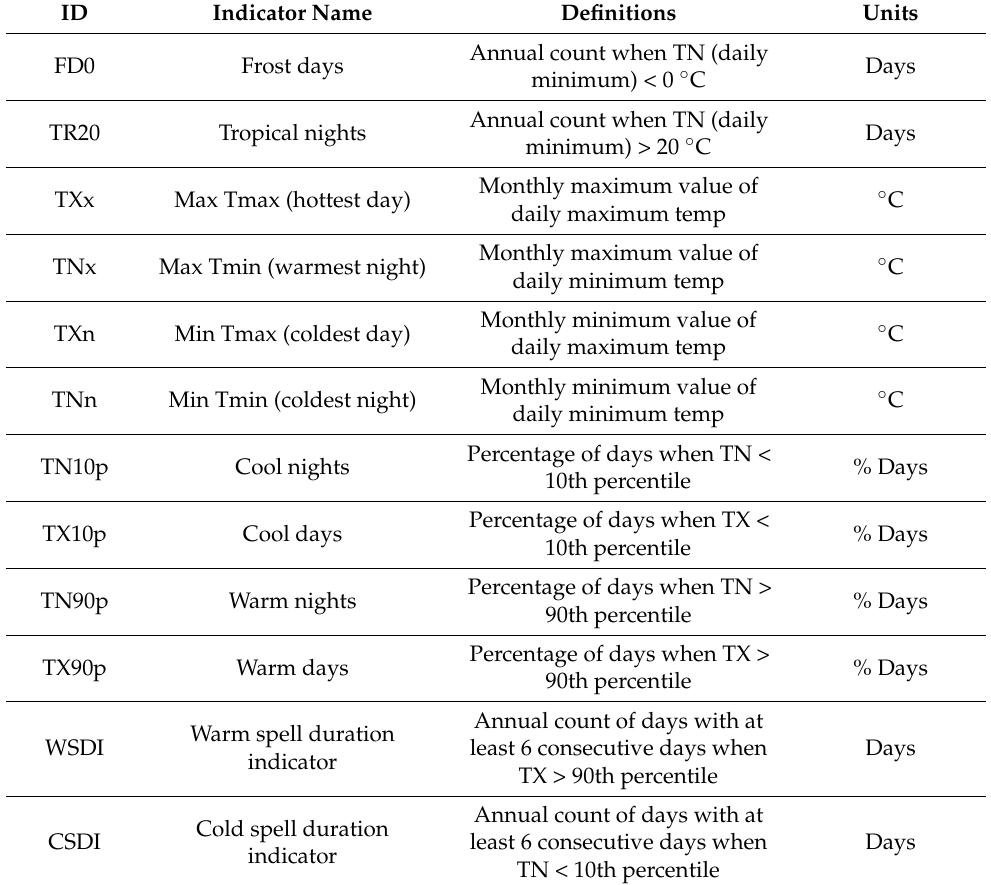
Table 1. Extreme temperature indices used in this